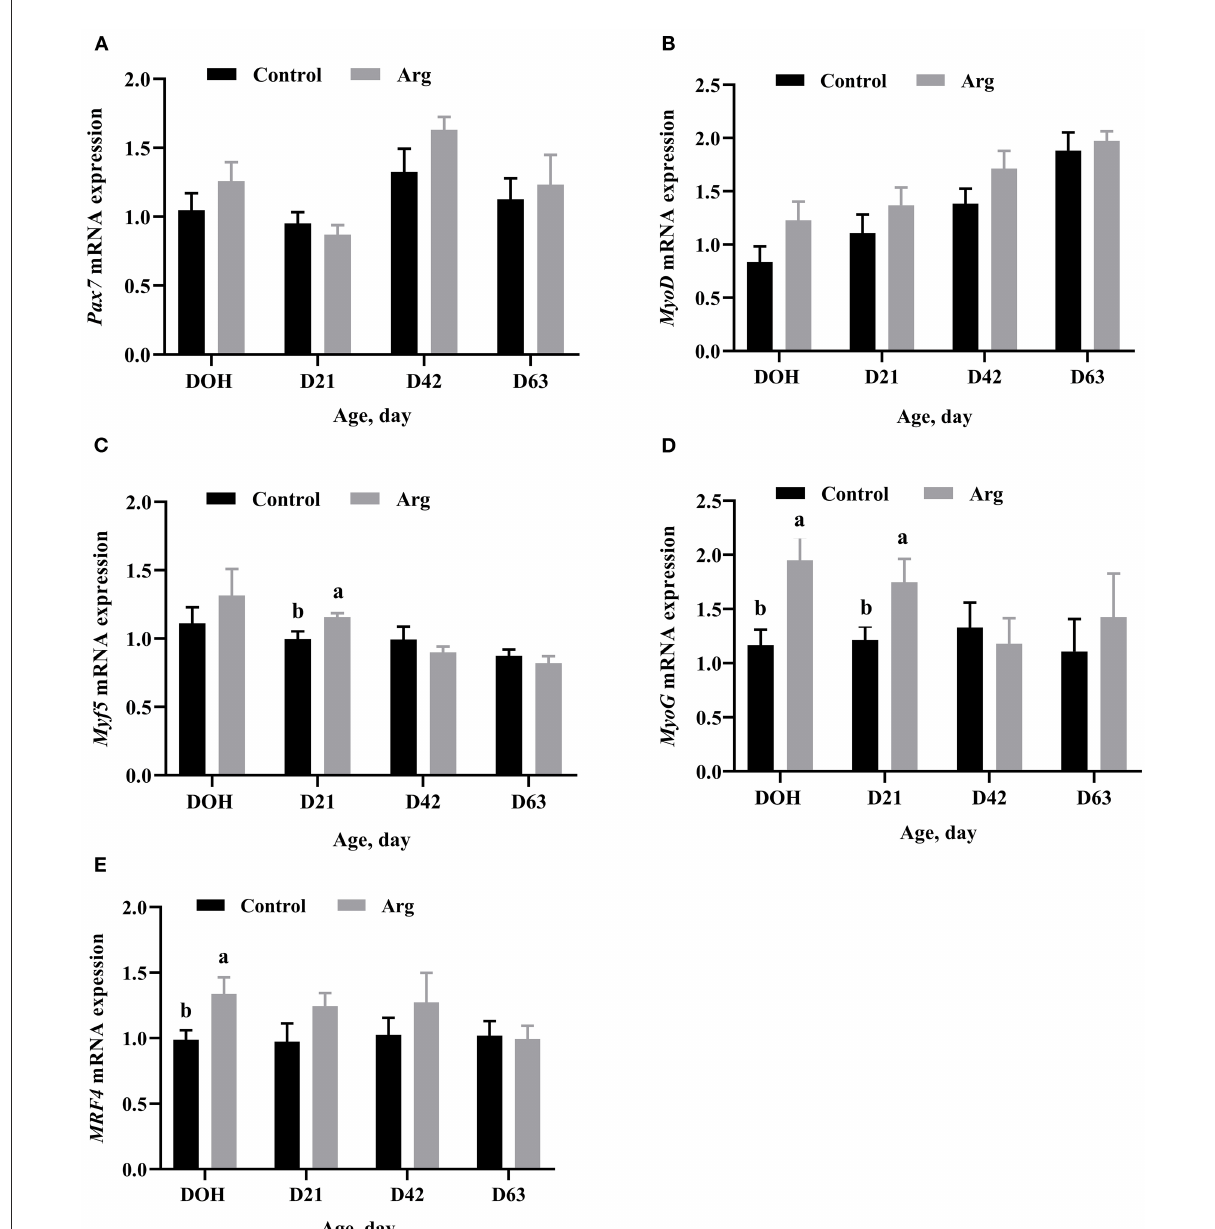
FIGURE3 Effects of in ovo feeding of L-arginine on gene mRNA expression related to myogenic regulatory factors on DOH, D21, D42, and D63 post-hatch in slow-growing chickens. (A) Pax7 , paired box 7; (B) MyoD , myogenic differentiation 1; (C) Myf5 , myogenic factor 5; (D) MyoG , myogenin; (E) MRF4 , myogenic regulator 4. DOH, day of hatching; D21, day 21; D42, day 42; D63, day 63. Control, non-injected group; Arg, 1% L-arginine-injected group. SEM, standard error of the mean. Values are means with n = 8 per treatment. Different superscripts with the same time point indicate significant differences between the two groups ( P <